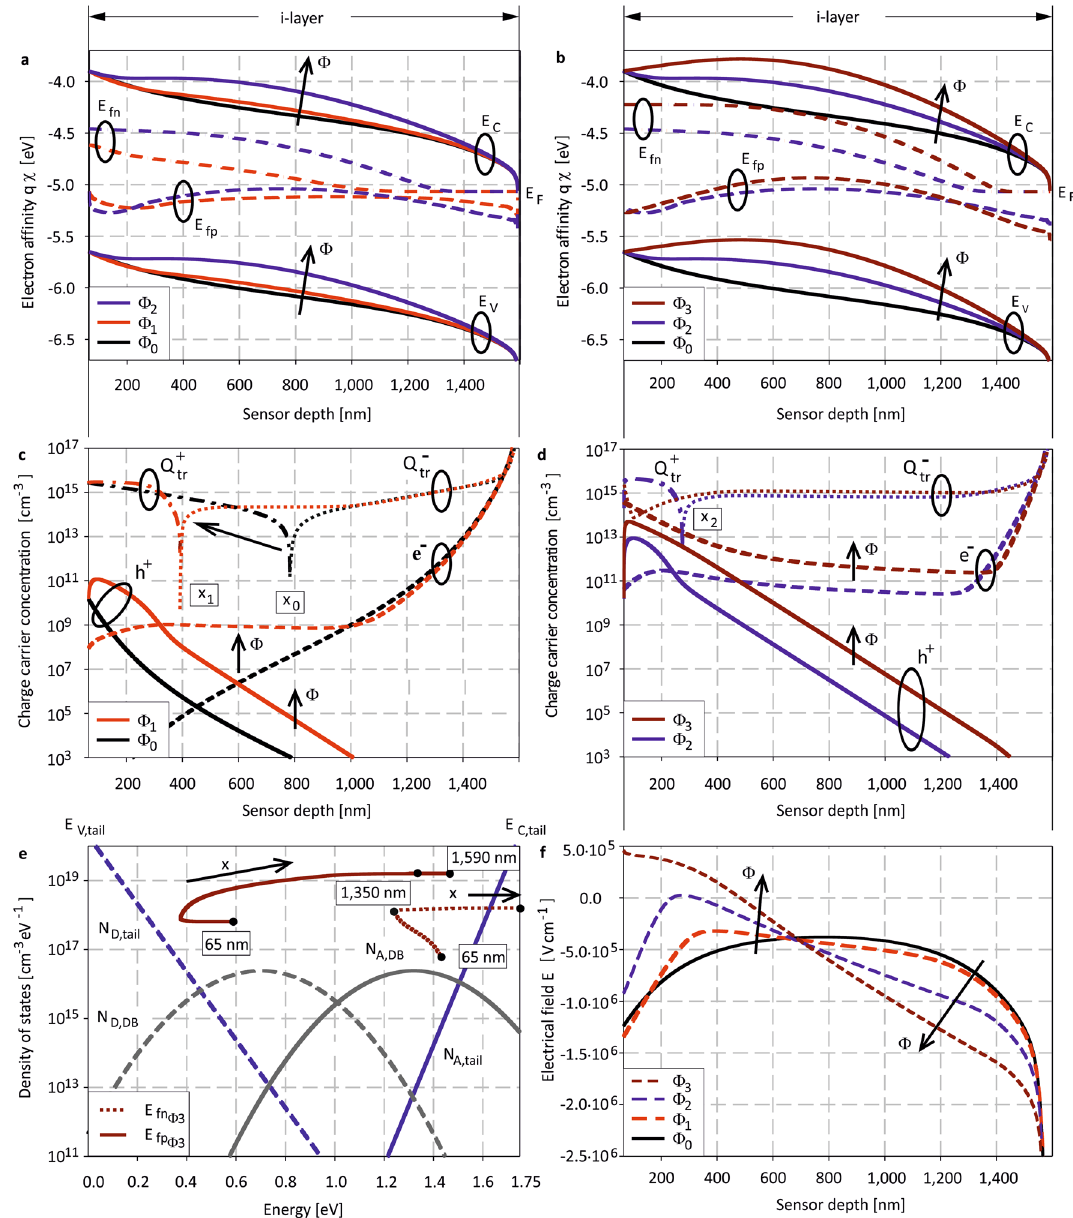
Figure 1. Simulated position and irradiance dependent ( a )–( b ) bandgap profiles including quasi Fermi level splitting under illumination, ( c )–( d ) charge carrier statistics, ( e ) density of state distribution including position dependent quasi-fermi levels and ( f ) electrical field distributions. At high intense illumination (cid:31) 3 , E fn converges towards the conduction band tail, E fp dissociates from the valence band tail resulting in local e − (dashed lines, ( c )-( d )) injection, h + (continuous line, ( c )–( d )) extraction, respectively. Trapping charge Q tr that is equivalent to the total charge carrier density, becomes negative throughout the total intrinsic device region. The electrical field gets significantly distorted impeding the electron transport and resulting in a nonlinear current breakdown; the